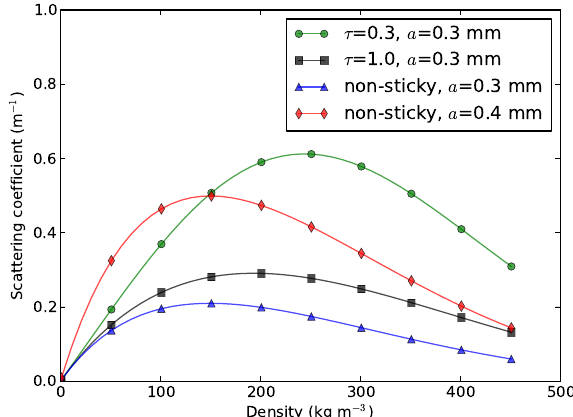
Fig. 8. Scattering coefficient at 37GHz as a function of the density for different stickiness parameters τ and grain radius a . The tem- perature is